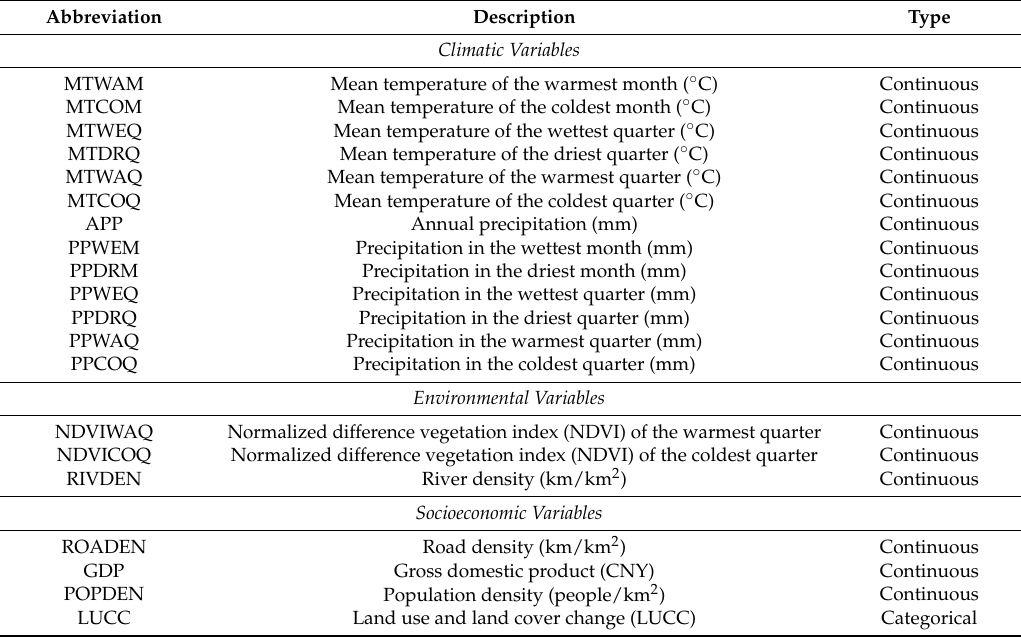
Table 1. Predictor variables used in this